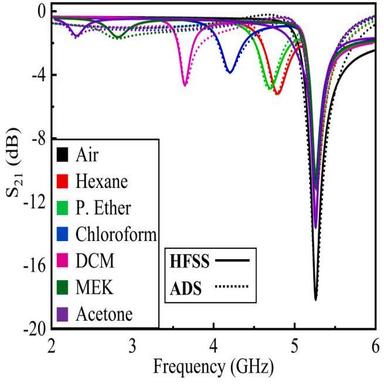
Comparison of HFSS and ADS simulation of different LUTs.